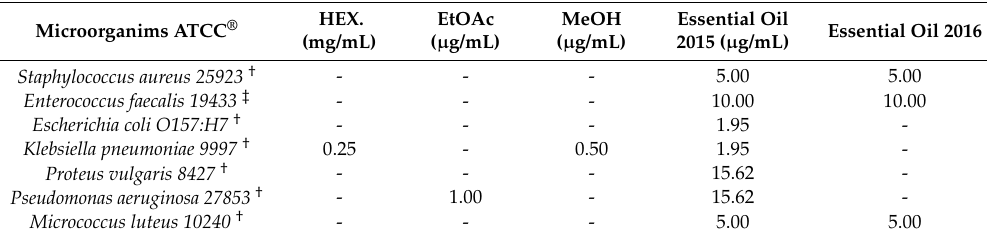
Table 3. Minimum Inhibition Concentration (MIC) values of total extracts and essential oils from C. taxifolium